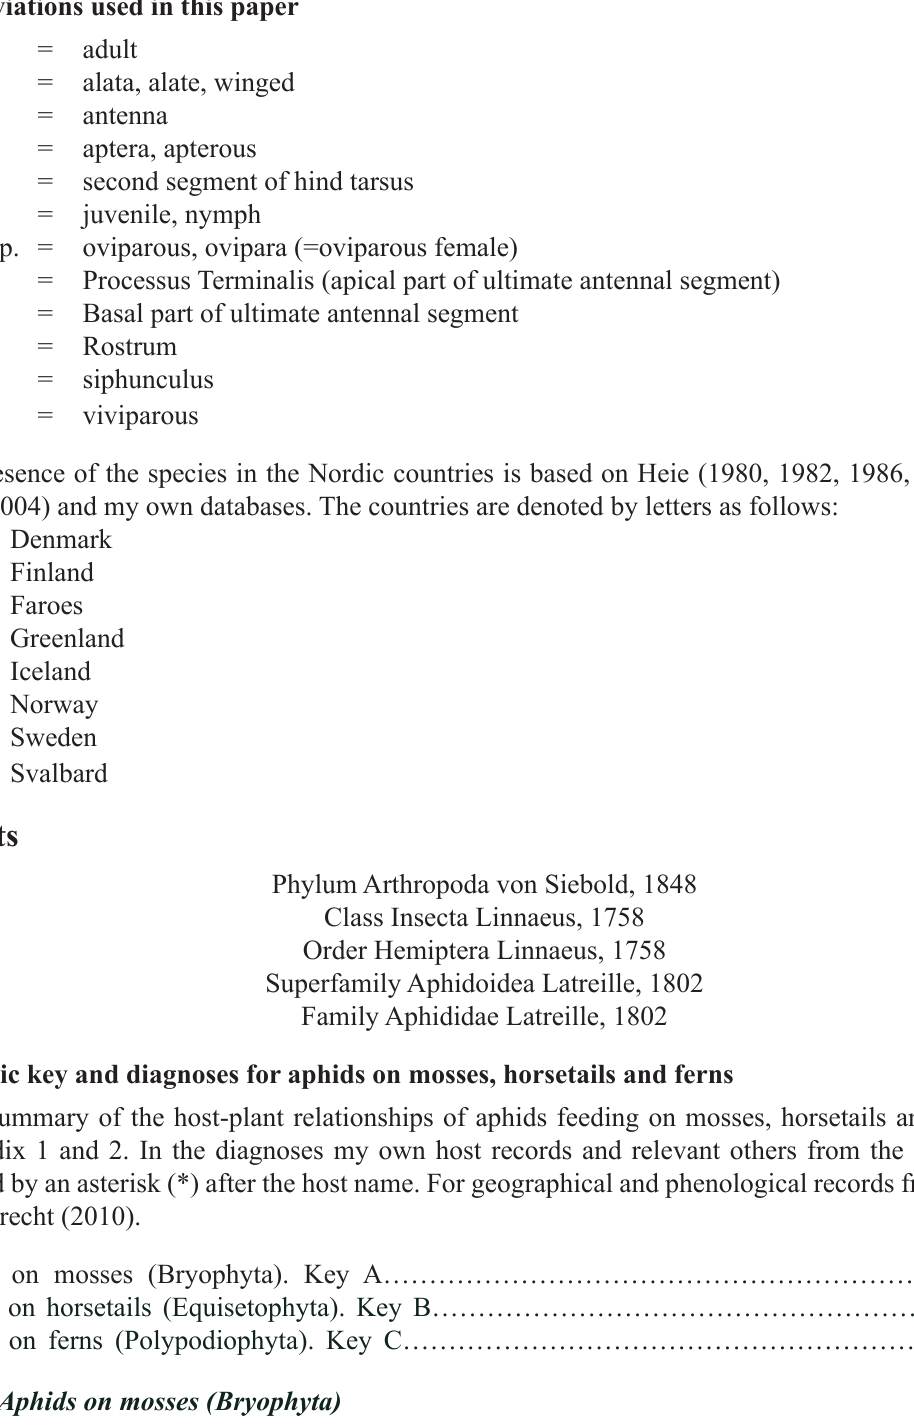
Key A. Aphids on mosses